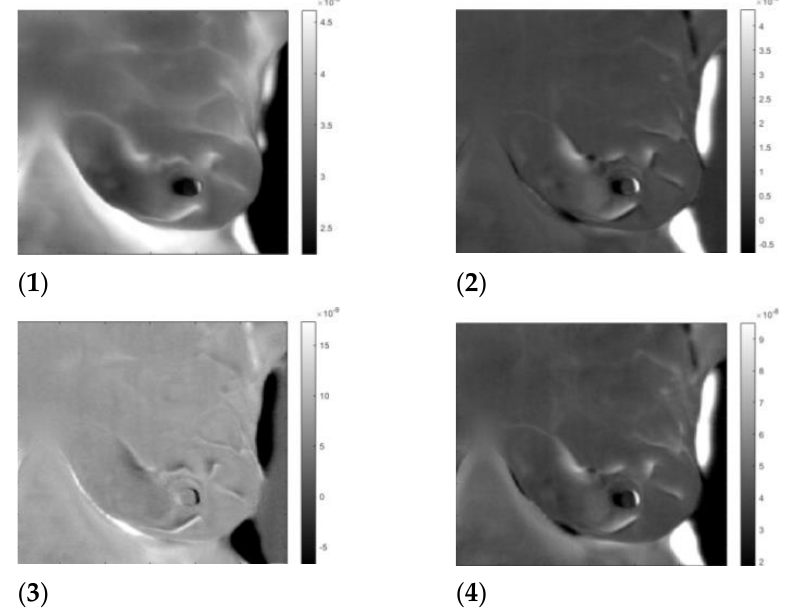
Figure 8. “Healthy” left breast of patient #T285. Images 1 to 4 after application of the inverse ICA transform. ( 1 ) and ( 2 ) are images of thermal reflection, while ( 3 ) and ( 4 ) are images of vasocon- striction.